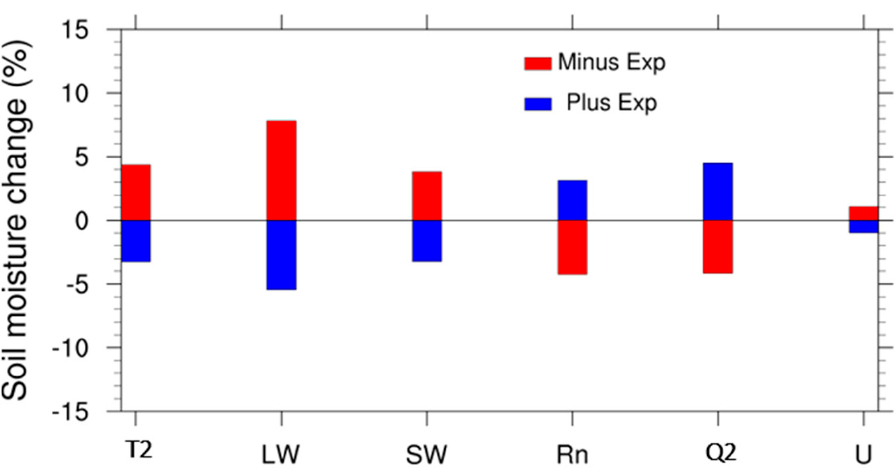
Figure 3. Annual soil moisture change (%) averaged over Indian regions from all the sensitive experiments.